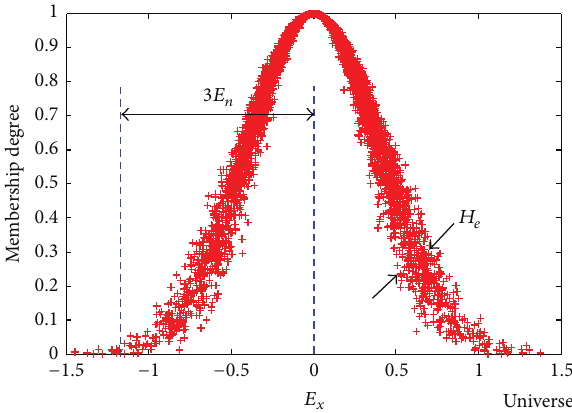
Figure 2: Three digital characteristics of normal